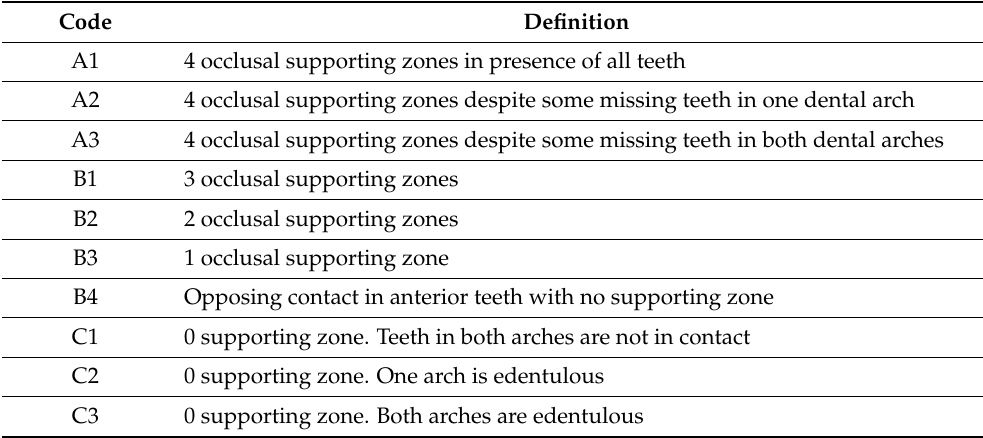
Table 1. Pattern of posterior dentition according to the Eichner’s index.